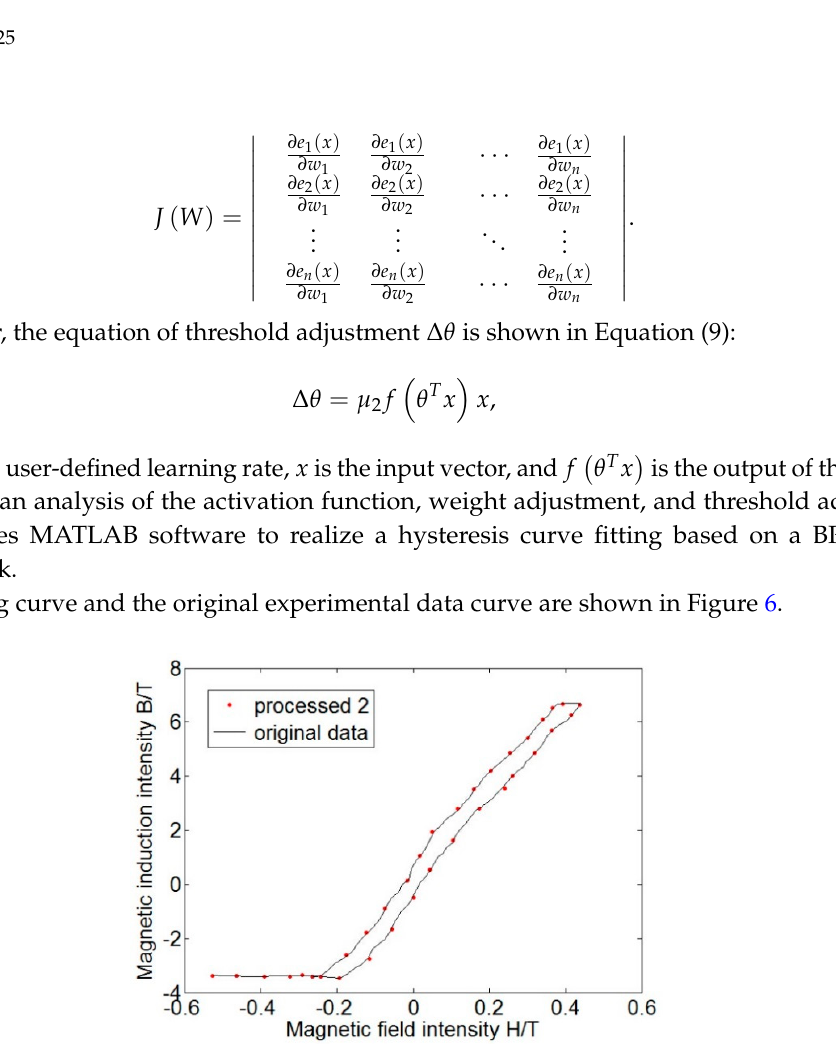
Figure 6. Fitting curve and original experimental data curve. “Processed 2” represents the fitting curve through the original BP artificial neural network. “Original data” represents the original experimental data curve.